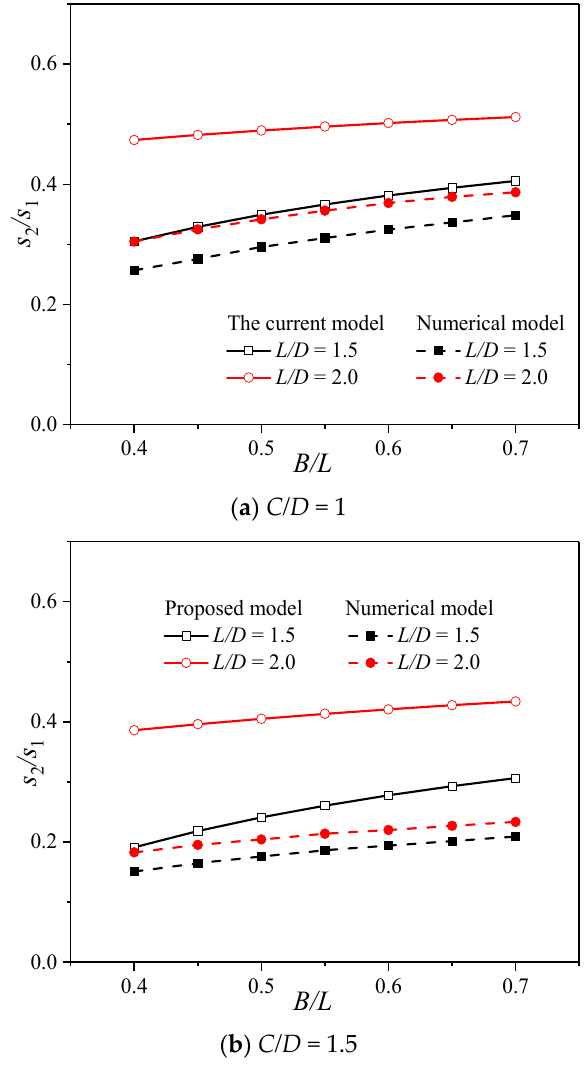
s s depending on / B L at typical =25 ϕ ° . Figure 11. Variations in Figure 11. Variations in s 2 / s 1 depending on B / L at typical ϕ = 25 ◦ 2 1